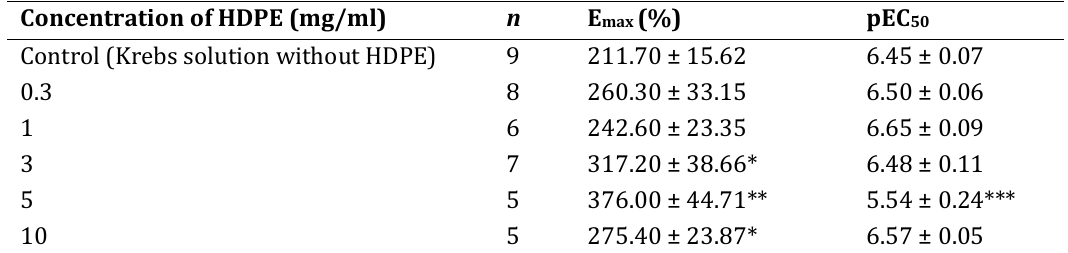
Table 2 : The maximum response (E max ) and pEC 50 of carbachol were derived from the respective concentration response curve. Unpaired t-test where comparison of the mean was made between control and the HDPE-treated group; * p < 0.05, ** p < 0.01, *** p < 0.001. Data were shown as mean ± SEM of n number of